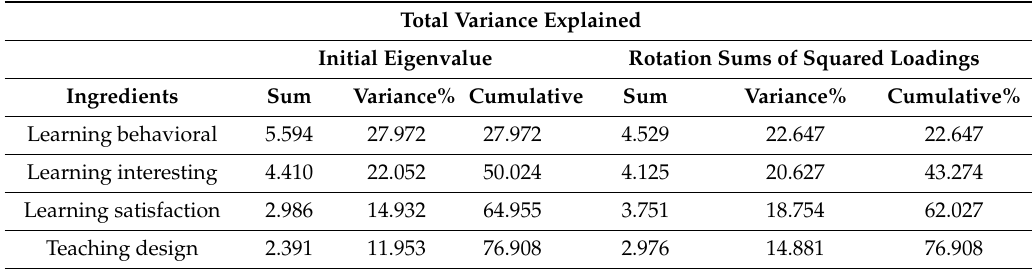
Table 7. Factor analysis—rotation sums of squared